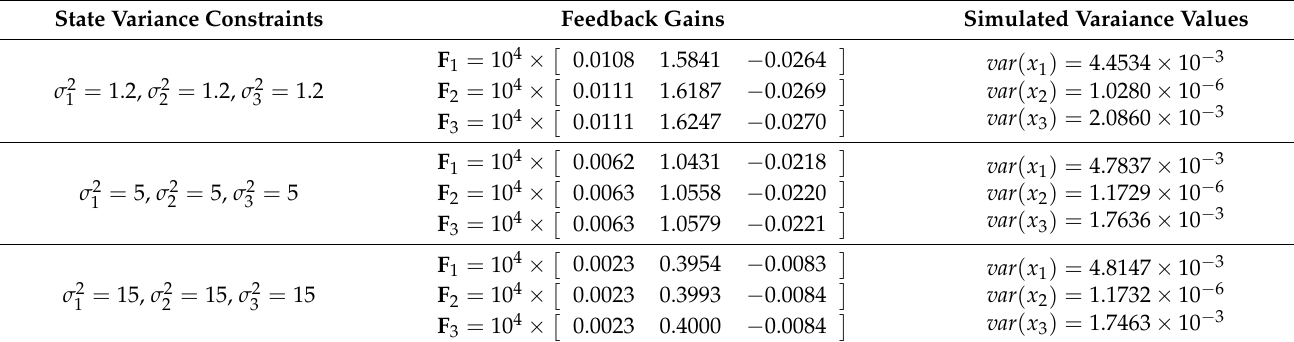
Table 1. Comparison results for different state variance constraints in Case